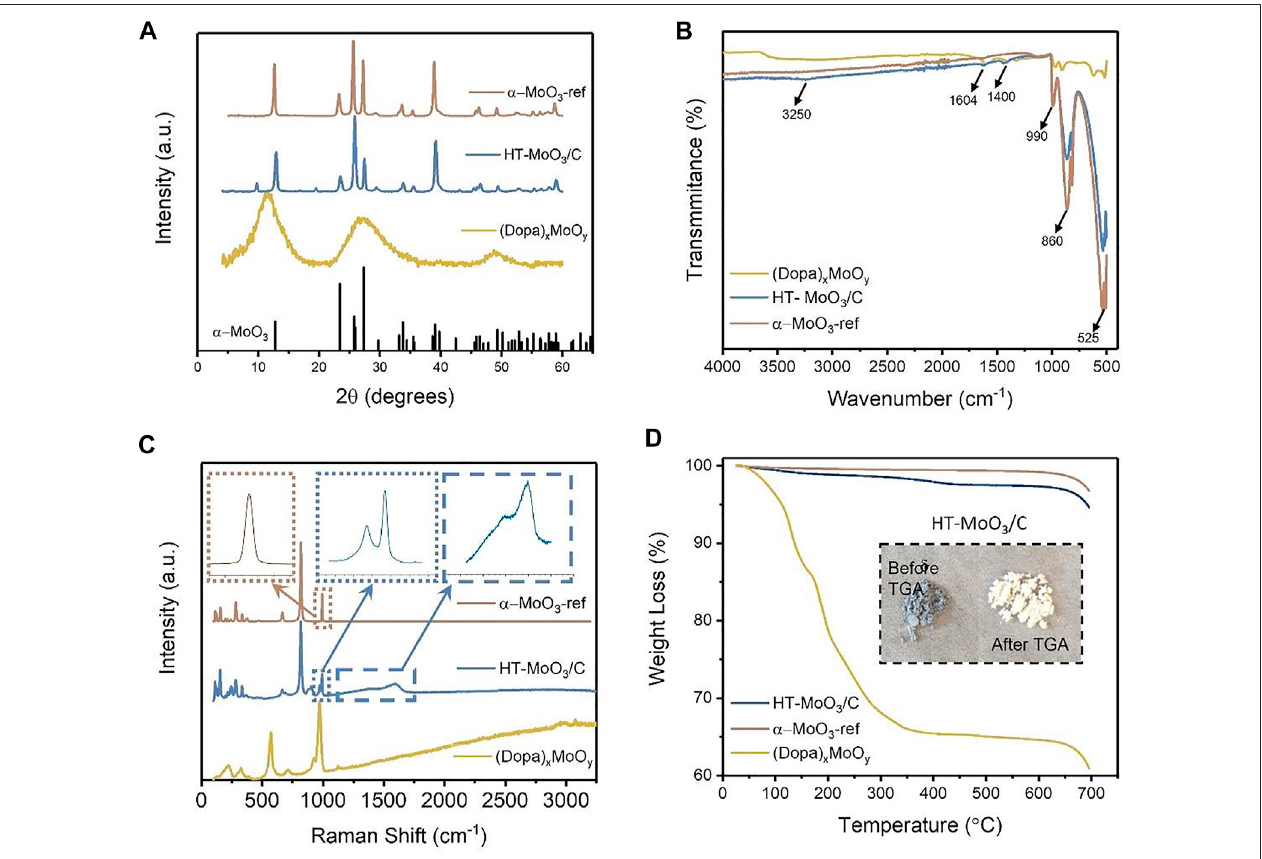
FIGURE2| Structuralandchemicalcharacteristicsofthe(Dopa) x MoO y ,HT-MoO 3 /C,and α -MoO 3 -ref: (A) XRDpatterns, (B) FTIRspectra, (C) Ramanspectra,and (D) TGA weight loss curves.